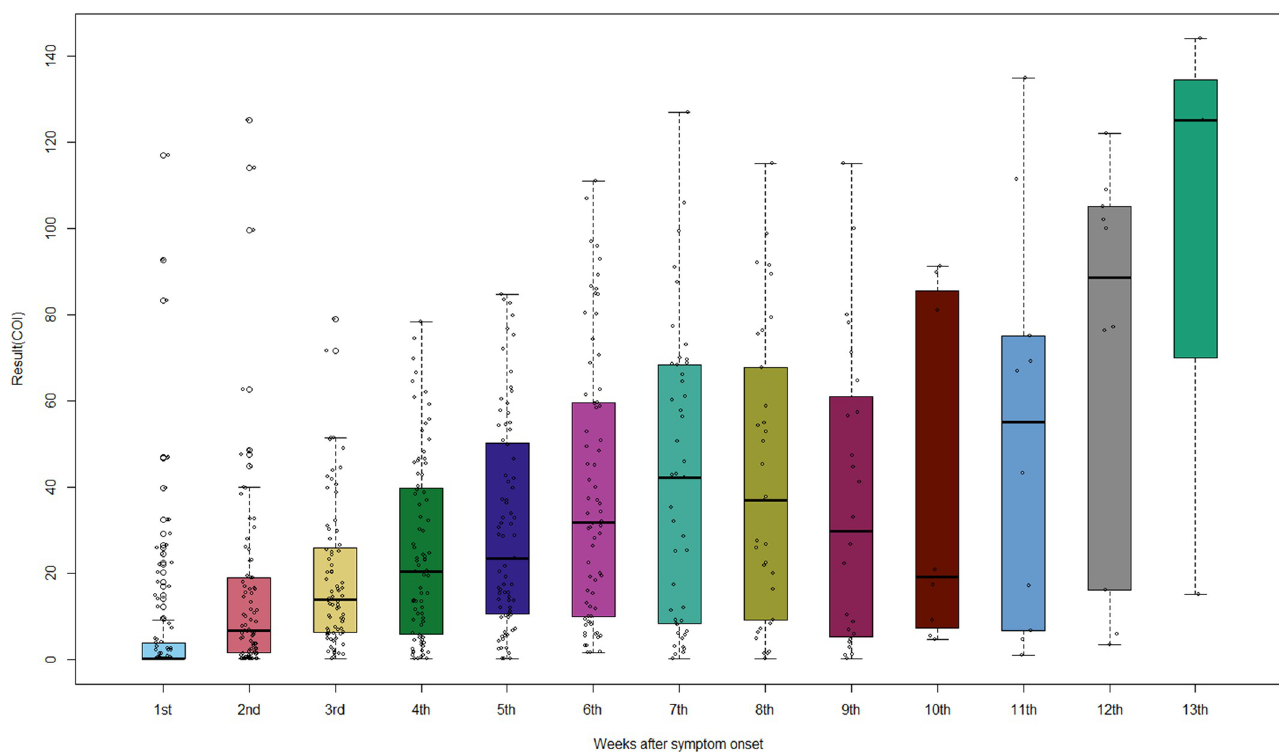
Fig 2. COI of anti-SARS-CoV-2 antibody over time since symptom onset. Data are means with 95% confidence intervals.